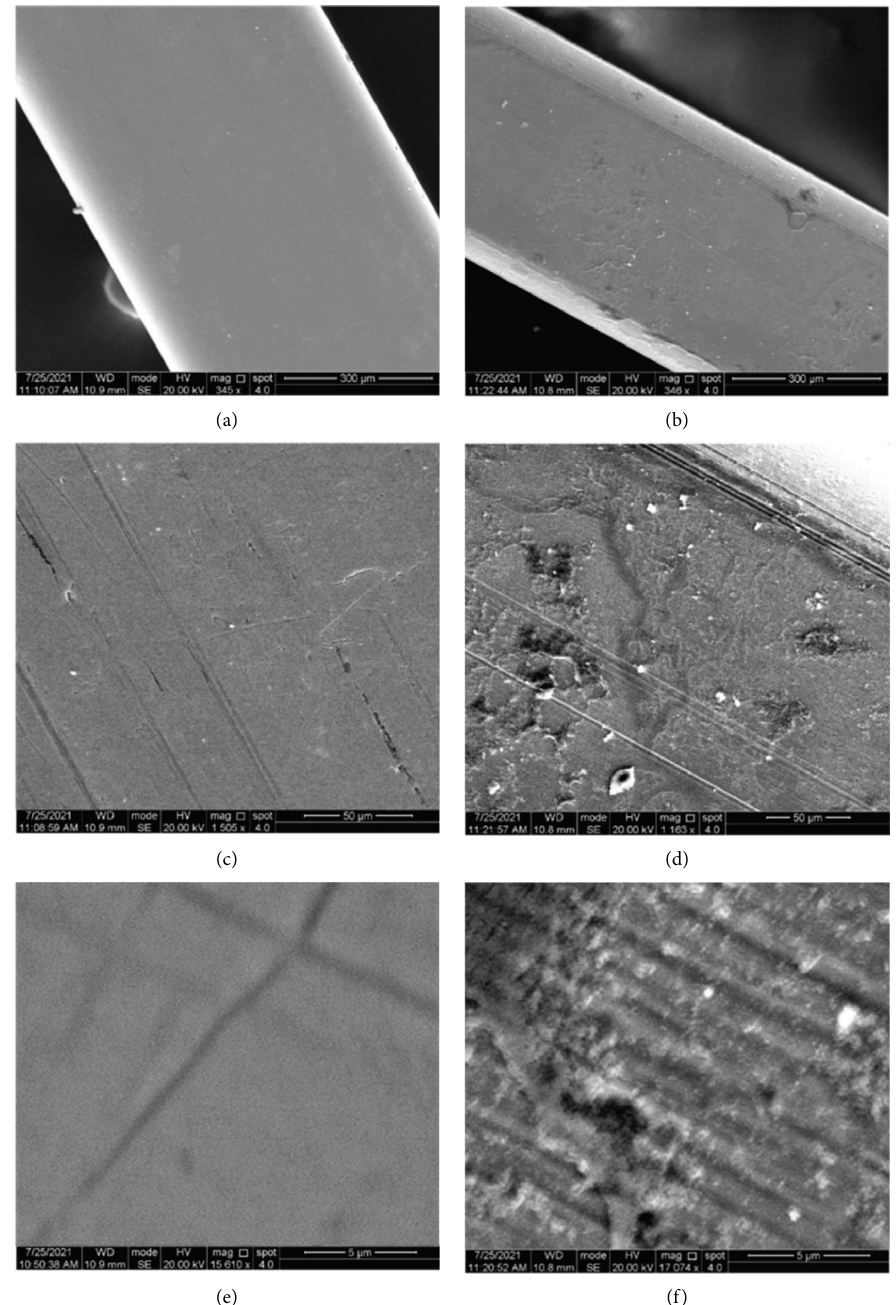
Figure 6: SEM images for the examined NiTiW at diferent magnifcation powers. (a, c, e) uncoated and (b, d, f)